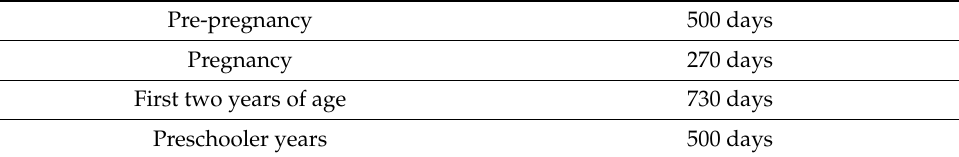
Table 8. Nutrition during the First 2000 days